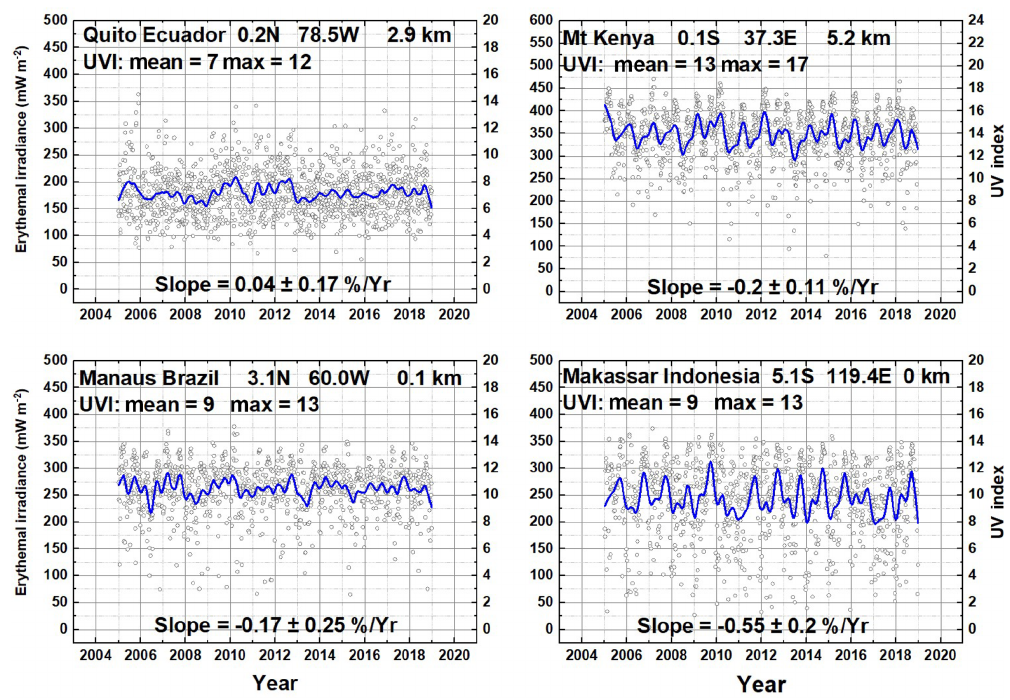
Figure 4. Four sites located close to the Equator. Mt. Kenya at 0.1 ◦ S, Quito, Ecuador at 0.2 ◦ N, Makassar, Indonesia at 5.1 ◦ S, and Manaus, Brazil at 3.1 ◦ N. The blue lines are a Loess(0.04) fit (approximately 6-month LS running average). Mean and maximum values are 14-year averages. Slope = B in Eq.